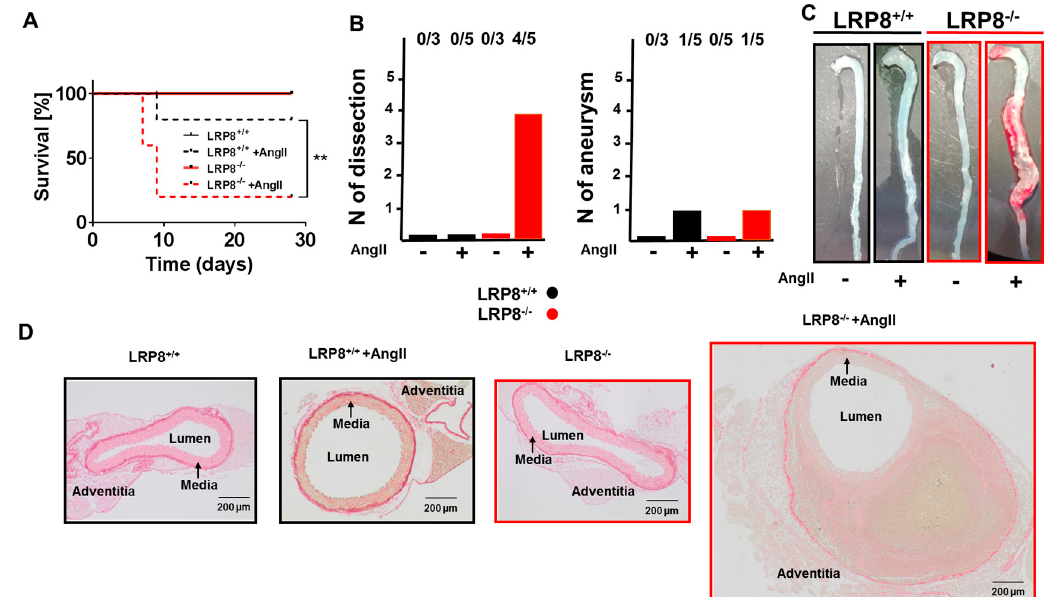
Figure 2. Formation of aortic dissections in LRP8 -/- mice in response to AngII. LRP8+/+ and LRP8 -/- mice were infused with AngII (1 mg/kg/d for 7day) vs. sham treatment. ( A ) Survival curves during 28 days of AngII infusion. n = 3 – 5 animals/group ( n = 3 in control groups and n = 5 in AngII infused groups). ** p < 0.01; LRP8+/+ + AngII vs LRP8 -/- +AngII. Kaplan — Meier curves were compared using a log-rank test. ( B ) Number of aortic dissection and aneurysm formations in LRP8 deficient and control mice infused with AngII. ( C ) Representative images of isolated aortas in control mice and after AngII infusion. ( D ) Representative images of sirius red staining of aortic sections (scale bar 200 µm).